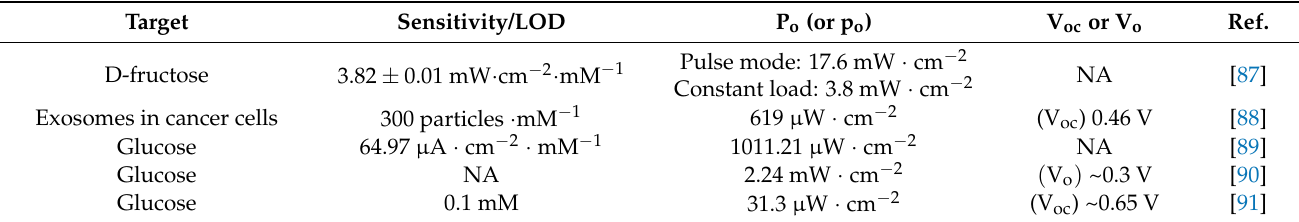
Table 7. Comparison of different BFCs that can be used to power wearable sensors.